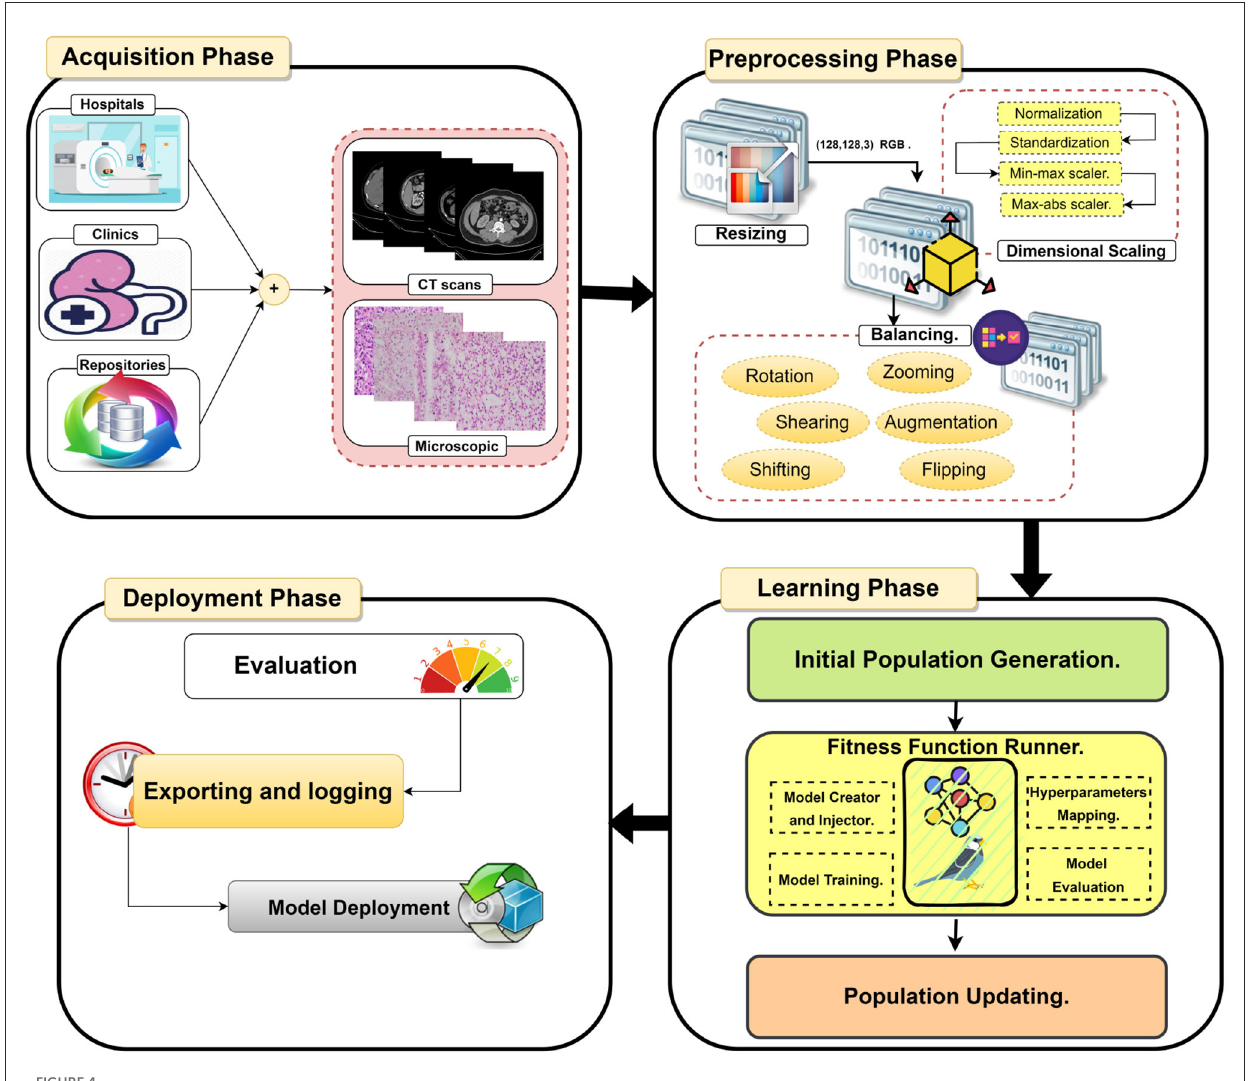
FIGURE4 The detailed phases of the proposed DRDC framework.